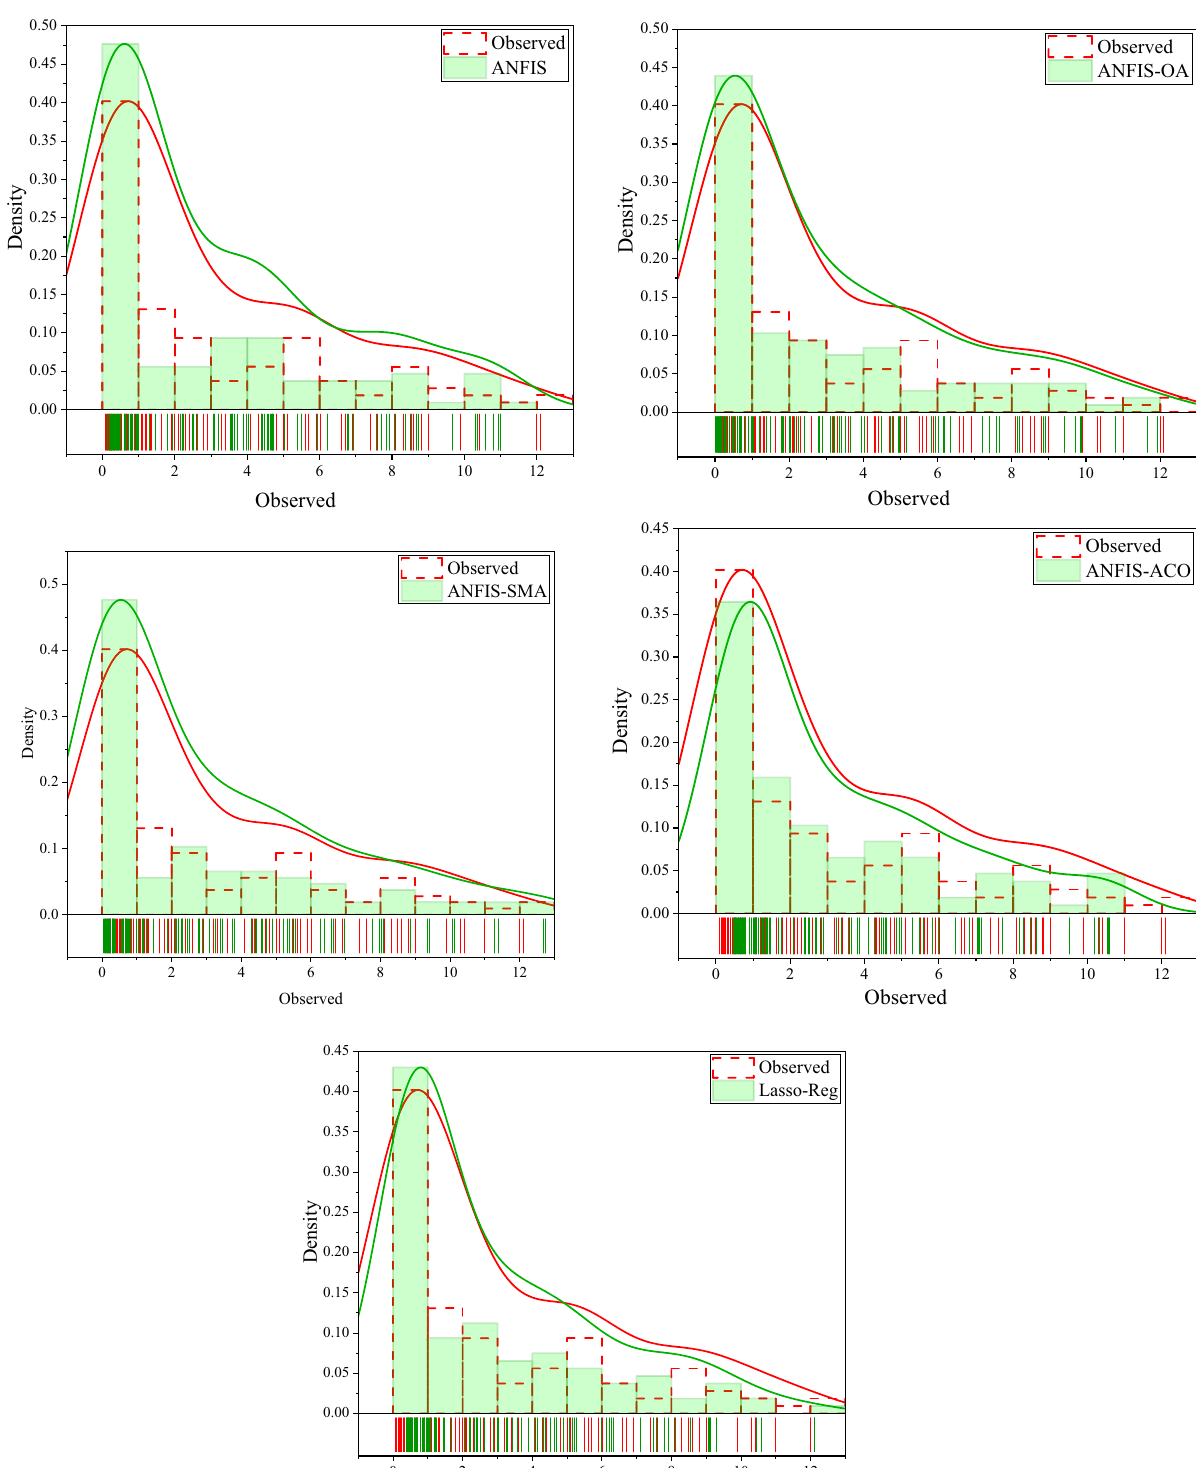
Figure 10. Control Rug and density distribution of Histogram Plot for all the provided models in the optimal scenario in the testing phase for predicting the salinity of